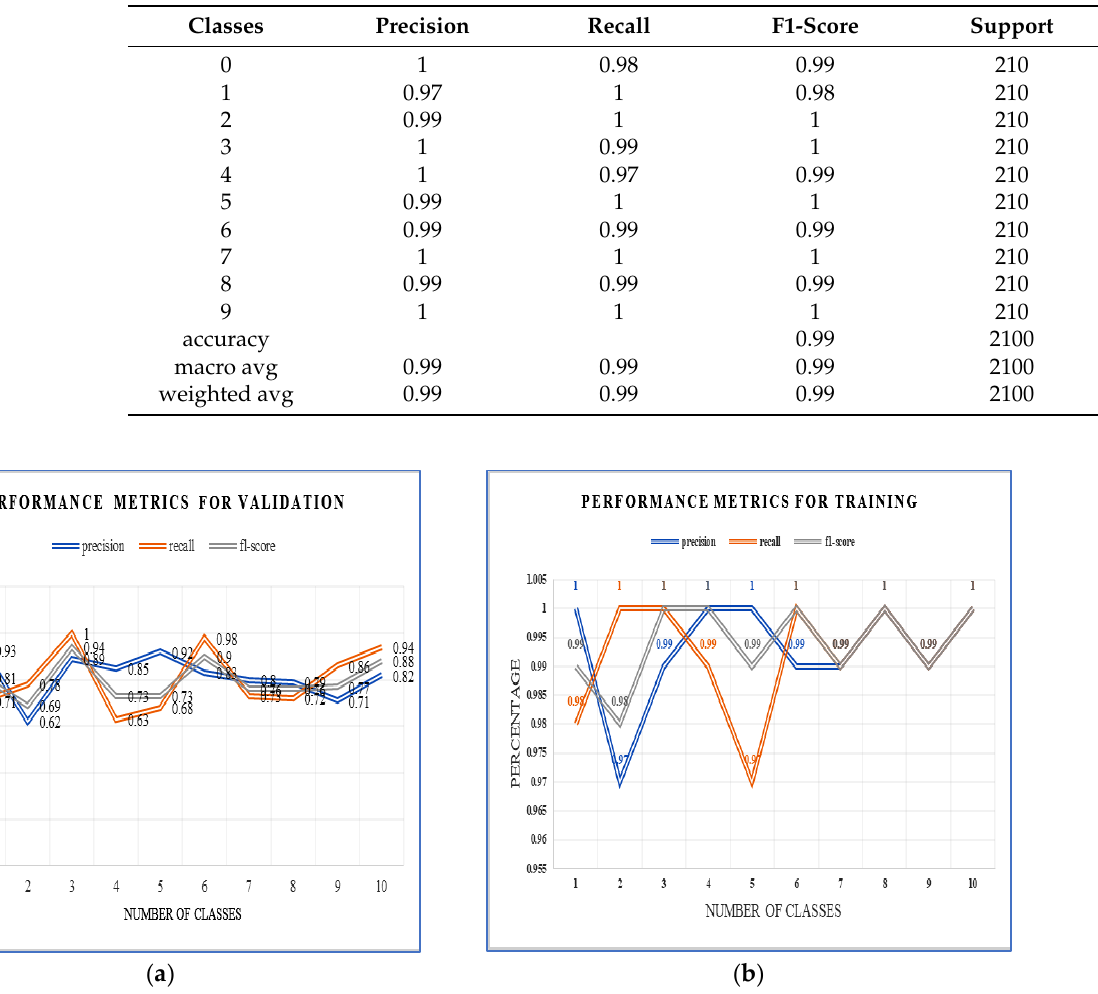
Figure 5. Graphical representation of validation and training accuracy.